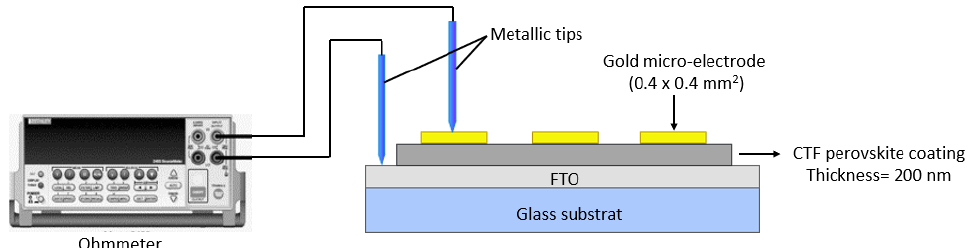
Figure 5. The electrical resistivity measurements of the CTF films.